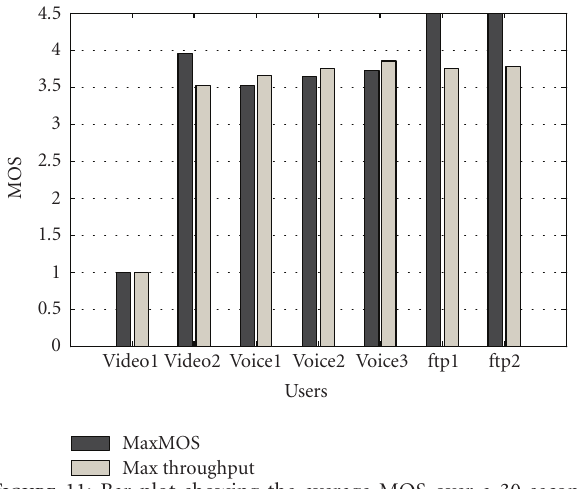
Figure 9: MOS gain per user, system symbol rate of 1000 Ksym- bol/s.